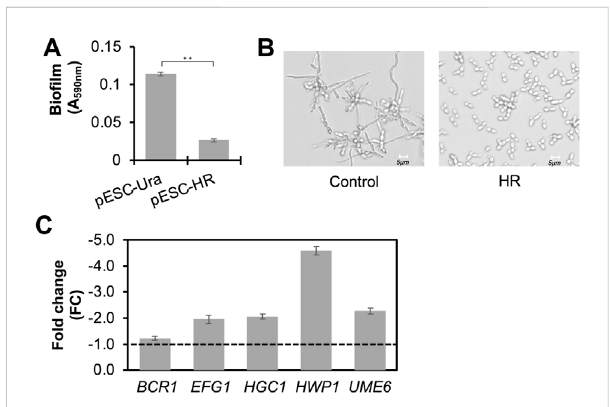
FIGURE 3 Functional analyses of the secreted MCFAs in the supernatant againstbio fi lmandhyphal formationsin C.albicans SC5314. (A) .Effect of the MCFA-containing supernatant from the engineered boulardii producing MCFAs (HR) on bio fi lm formation. Control, the strain carrying pESC-URA. **, p < 0.01 (Student ’ s t-test). (B) . Effect of MCFA- containing supernatant from the engineered boulardii producing MCFAs (HR) on hyphal formation at pH5.5. (C) . Real-time PCR analysis of the gene pro fi le in C. albicans co-cultured with MCFA-containing supernatant from the engineered boulardii strain producing and secreting MCFAs (HR). The expression of genes related to bio fi lm and hyphal formations at 12 h was analyzed. The supernatant from the strain carrying pESC-URA was used as a control. Reference gene, ACT1 . A dotted line indicates FC1.0, representing the fold change of genes from the control. Minus indicates the genes ’